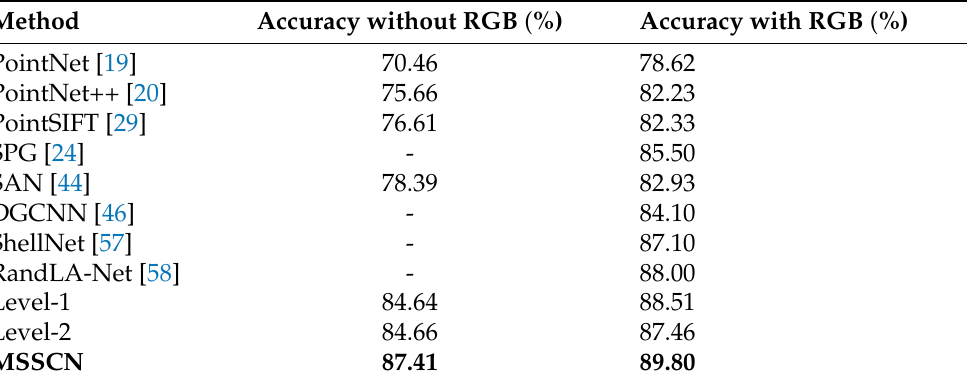
Table 1. Comparison of the accuracy of different methods on the S3DIS dataset